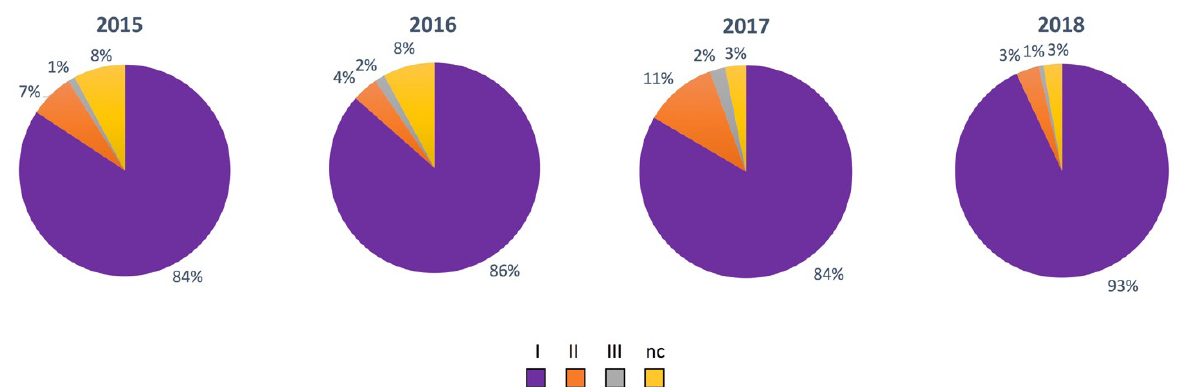
Fig. 2: Quality of Italian saffron produced from 2015 to 2018 according to ISO 3632 1,2:2010-2011. Key: I, first quality category; II, second quality category; III, third quality category; nc, not classifiable.